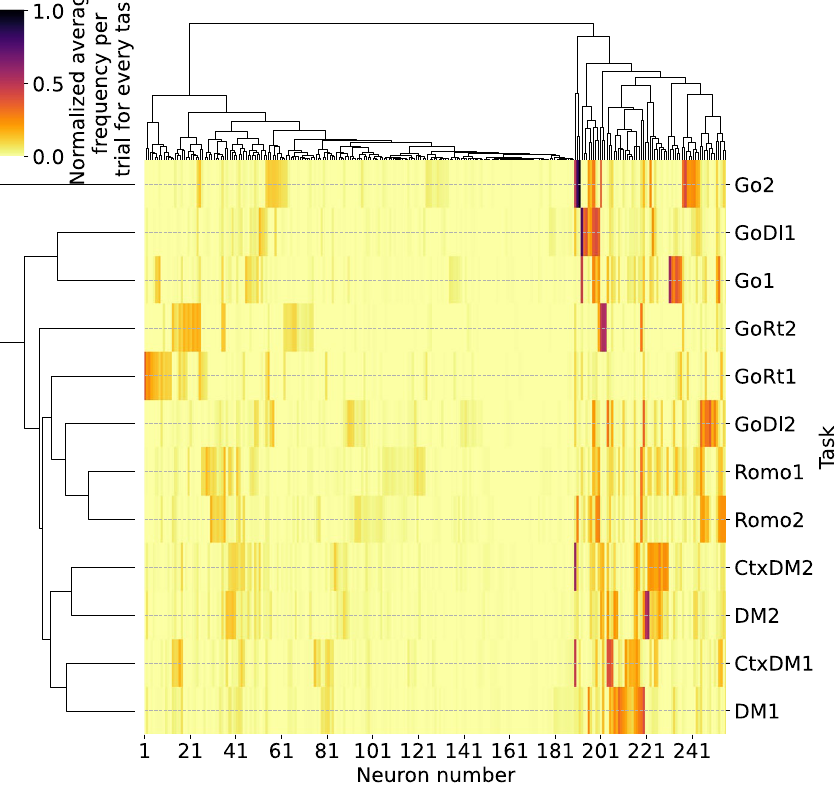
Figure 8. Cluster structure of the neural network after training, where the color denotes the normalized average firing rate of each neuron during each task. The dendrograms on the left and on the top show the hierarchical structures with respect to the tasks and neurons, respectively. The network consists of 256 neurons and is trained with the regularized loss function. The average of 100 test trials of each task is